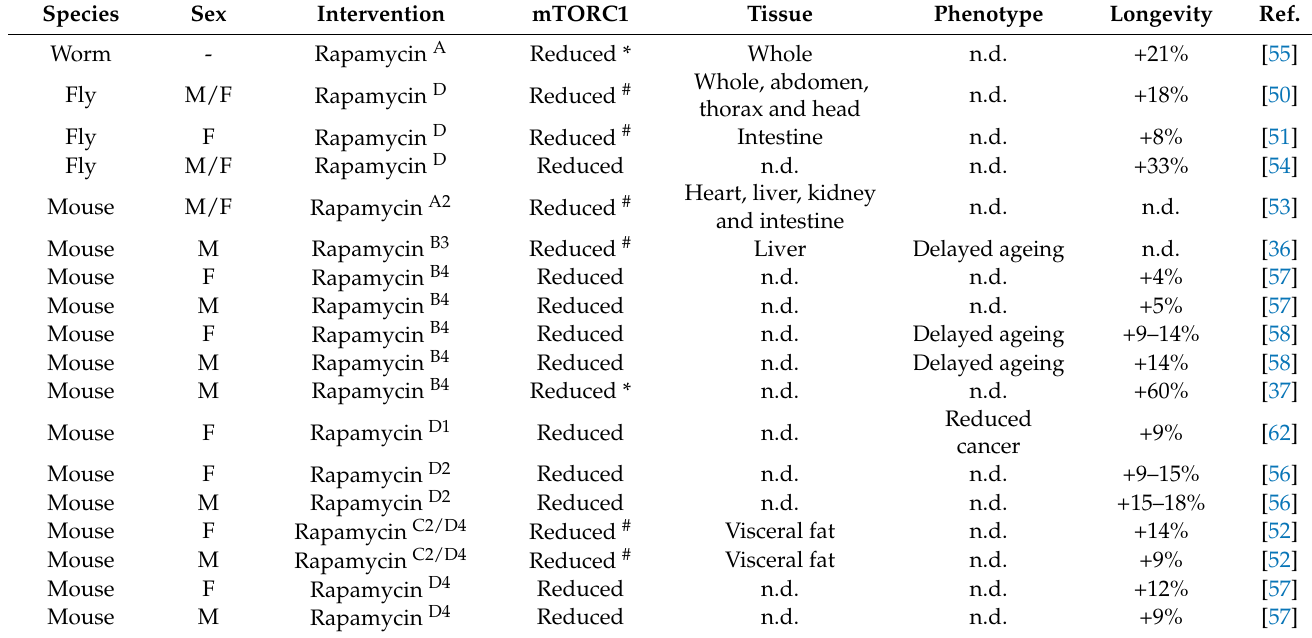
Table 4. mTOR regulation through rapamycin. Increased or reduced mTOR content can refer to either transcript content gene expression, protein content, protein phosphorylation or activity after insulin stimulation. Letters refer to: maximum longevity (ML), in years; female (F); male (M); not determined (n.d.). Nutritional intervention (NI) duration is grouped according to different